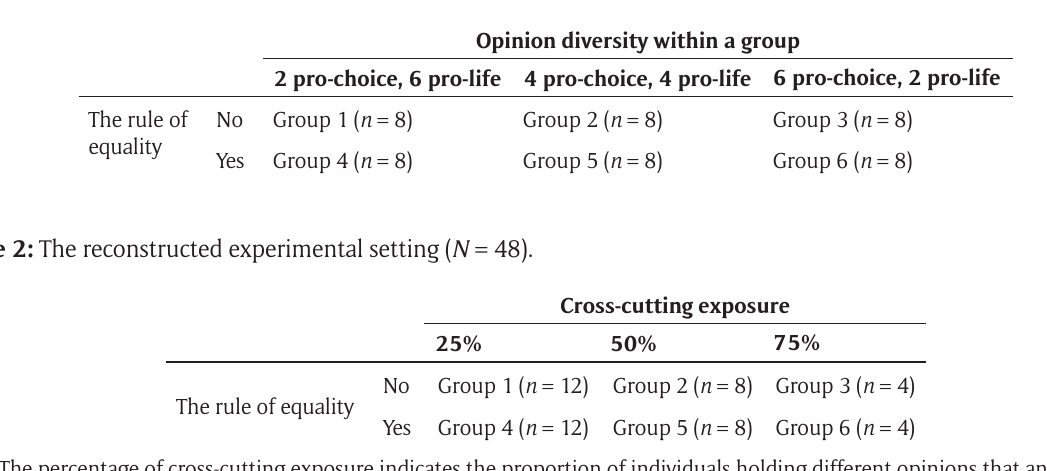
Table 1: The original experimental setting ( N = 48).